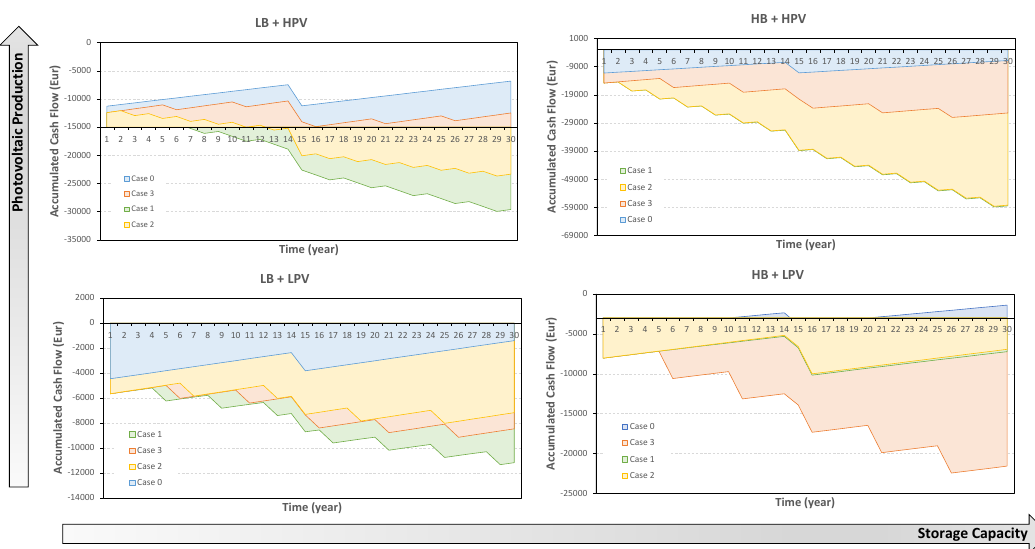
Figure 12. Accumulated cash flow over the PV system lifetime for all scenarios within the High Electricity Price (HEP).